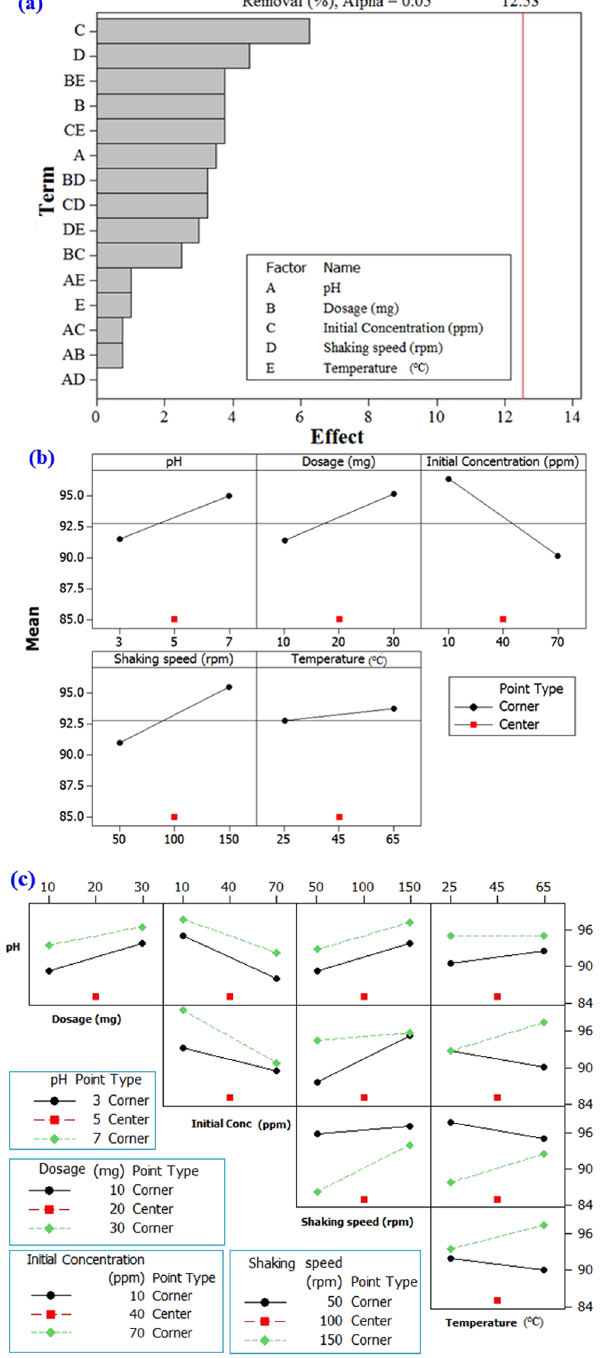
Figure 8. The factorial design for the optimization of the adsorption of Hg(II) showing: ( a ) the Pareto chart, ( b ) the half-normal plot of the effects; ( c ) the factorial design showing the interaction plot for a